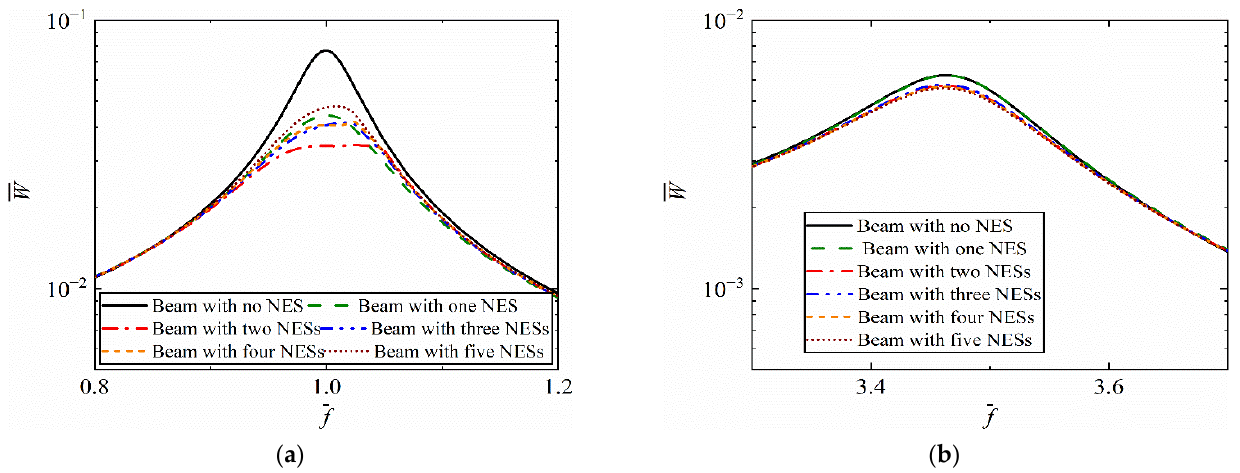
Figure 9. ( a ) Response at the first resonance frequency under varying number of NESs; ( b ) response at the second resonance frequency under varying number of NESs.